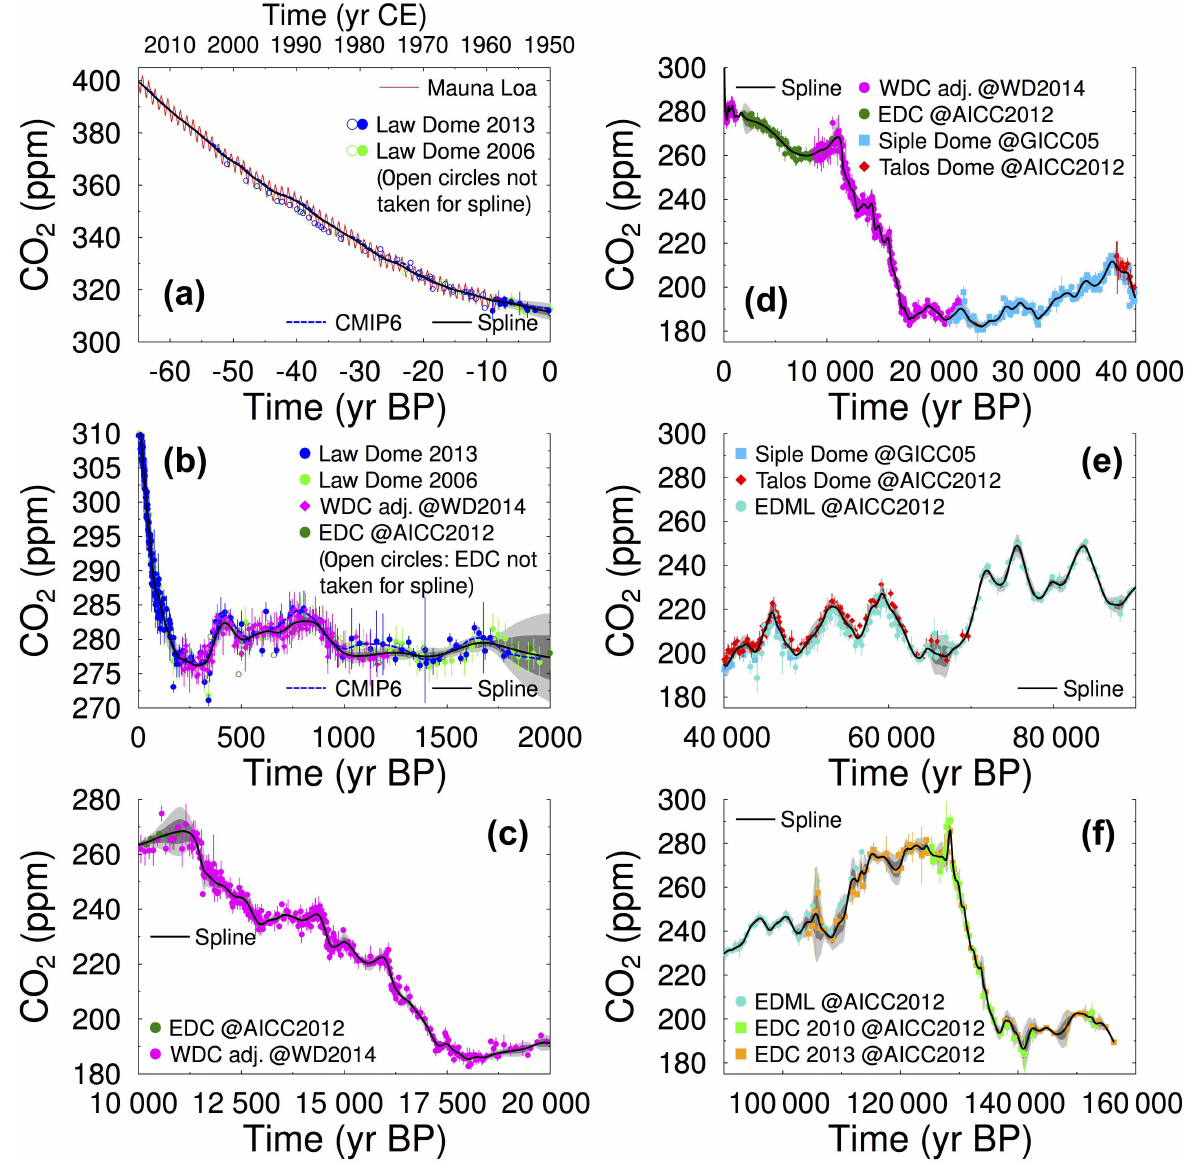
Figure 2. Details of the CO 2 spline. Light and dark grey bands around the spline represent ± 1 σ and ± 2 σ , respectively; error bars around the ice core data points are ± 2 σ . (a) Instrumental times (1950–2016CE); (b) 0–2000BP; (c) Termination I; (d) 0–40kyrBP without the Law Dome data showing the anthropogenic rise; (e) 40–90kyrBP; (f) 90–160kyrBP. WDC data have been adjusted to reduce offsets; see text for details. Dashed line labelled CMIP6 in panels (a) and (b) is the compiled CO 2 record to be used in CMIP6 experiments for the last 2kyr (Meinshausen et al.,